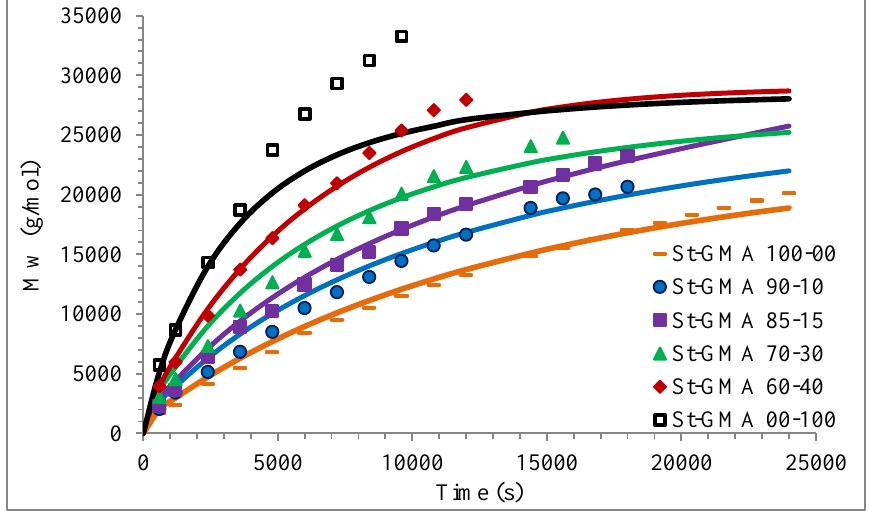
Figure 8. Profiles of M w versus time for the different St-GMA samples. Symbols and solid lines correspond to experimental and calculated profiles, respectively.